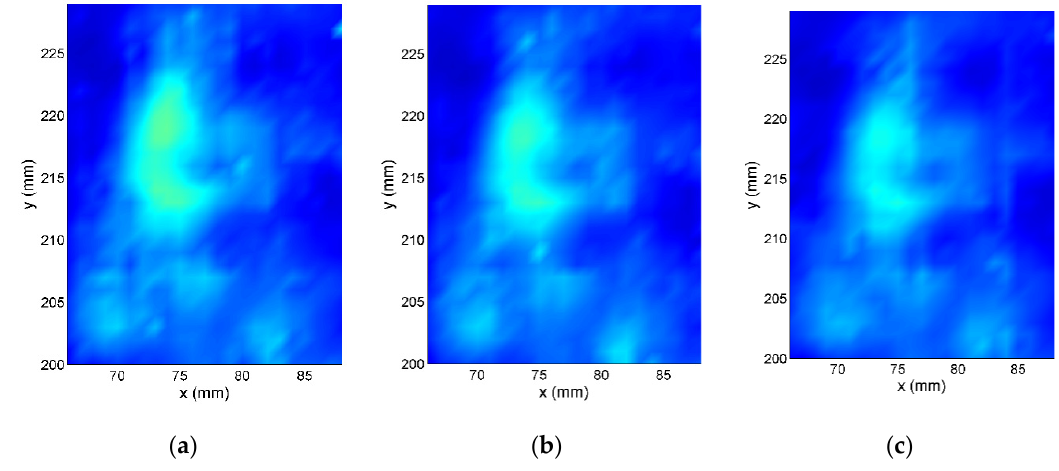
Figure 16. Close-up of BVID (5 J) region ( a ) 1 h, ( b ) 6 h, ( c ) 29 h after the moment of impact.